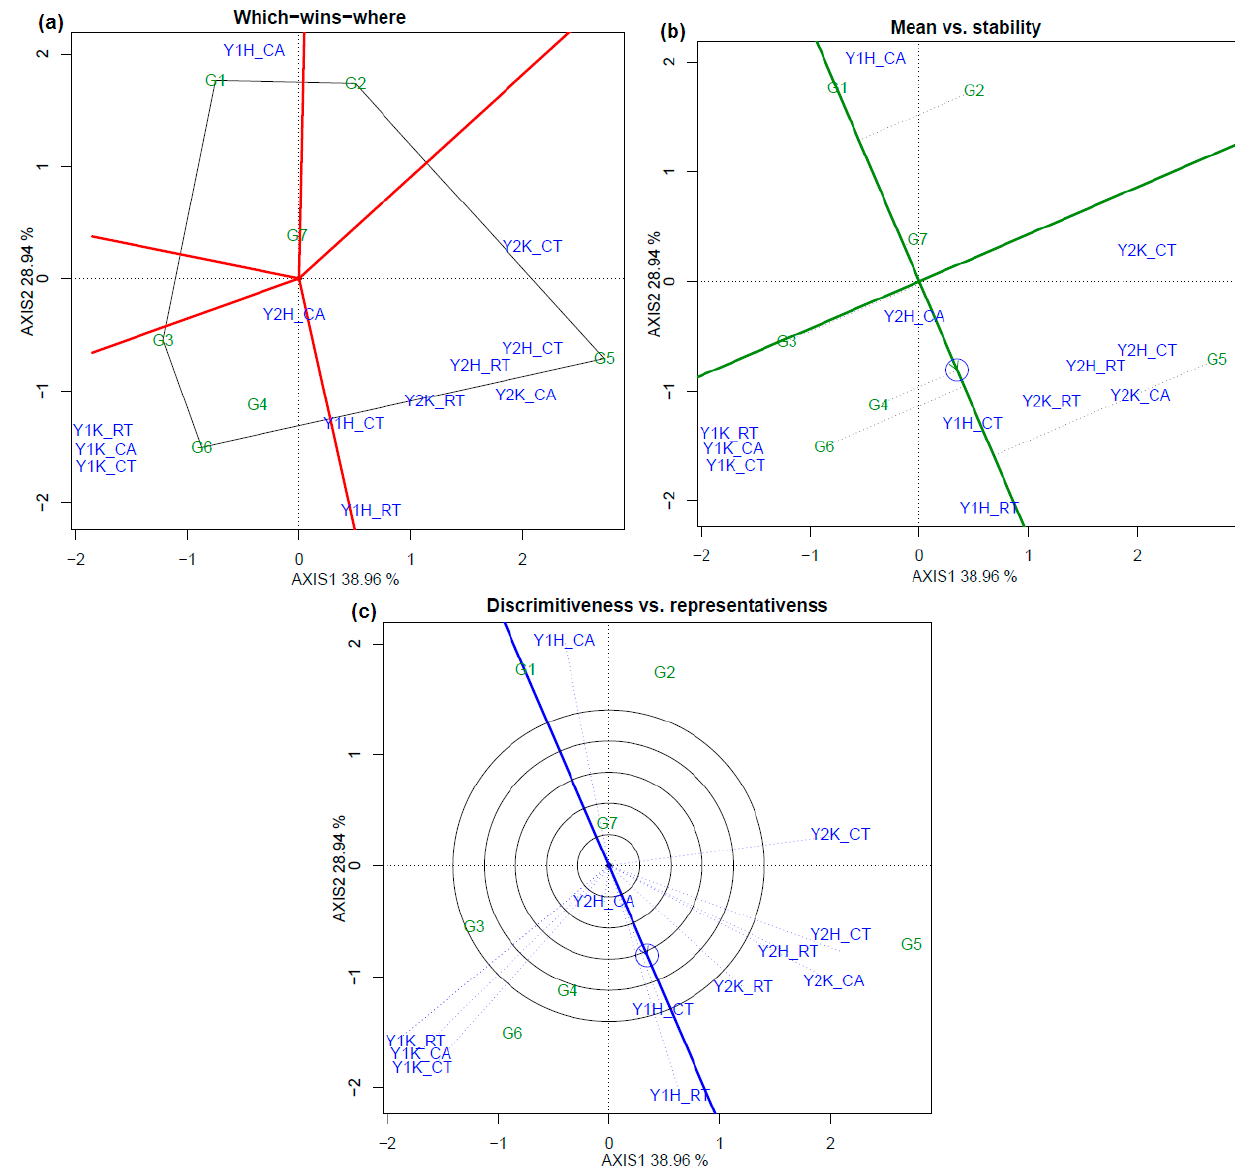
Figure 3. GGE biplot for grain yield of seven barley genotypes (G1–G7) across 12 environments showing ( a ) “which-wins-where” pattern, ( b ) “mean yield vs. stability” of genotypes and ( c ) “dis- crimitiveness vs. representativeness” of test environments for grain yield.